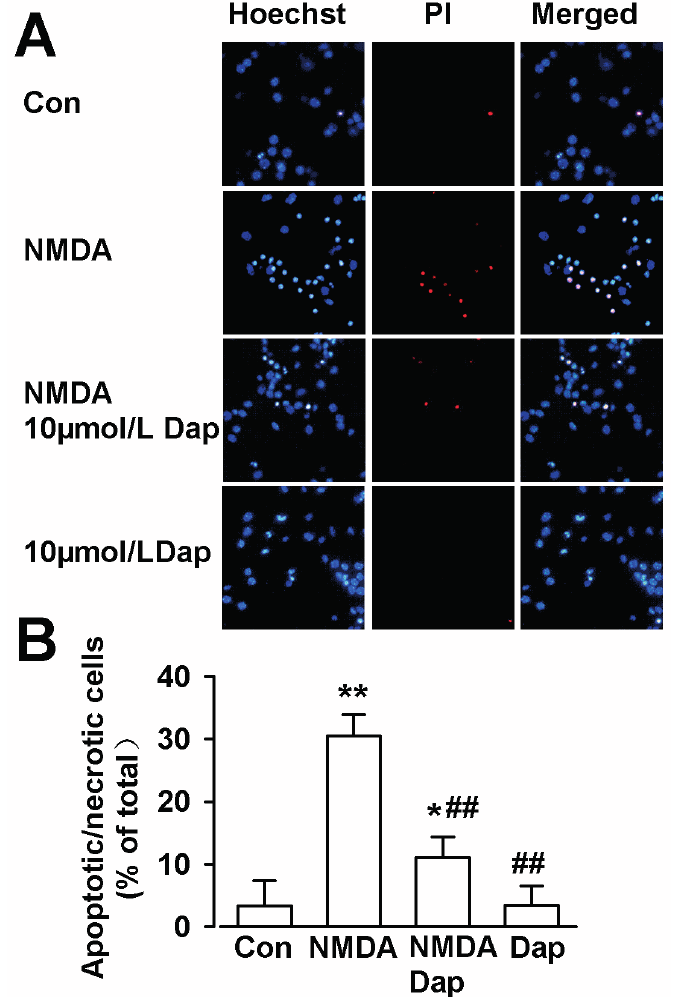
Figure 2. Hoechst 33258 and PI double staining in cultured cortical neurons. ( A ) The representative fluorescence images obtained after Hoechst 33258, PI, and double staining in cortical neurons. Scale bar: 20 μ m. ( B ) The percentage of apoptotic neurons in total neurons for control, NMDA, NMDA + Dap (10 μ M), and Dap (10 μ M) treated groups. The apoptotic numbers were counted from three independent experiments. * p < 0.05, ** p < 0.01 compared with control, ## p < 0.01 compared with NMDA